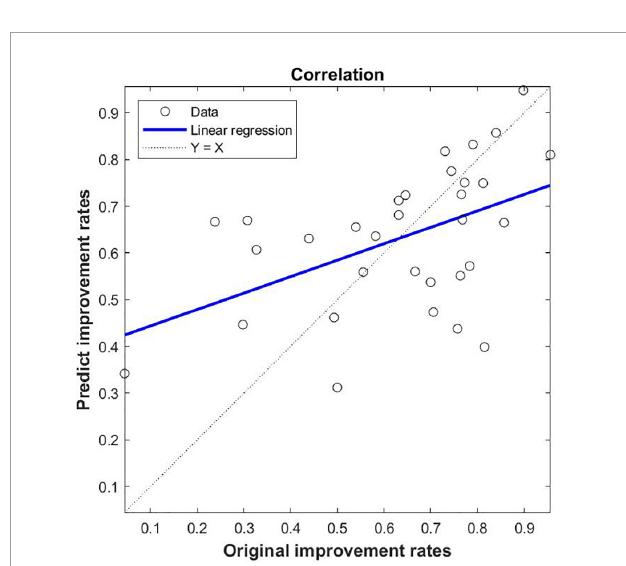
FIGURE5 SVR-based prediction of uric acid (UA)-related function connectivity (FC) on the rate of improvement of motor symptoms in patients with Parkinson’s disease (PD) following STN-DBS. The predicted value of SVR was correlated with the original value; the feature of SVR was that the zFC of PD was different between PD and HC, and the ROIs were significantly correlated with DC and